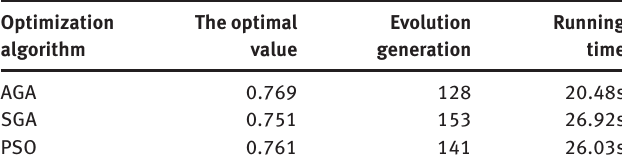
Table 3: The Running Results of AGA and SGA. Optimization